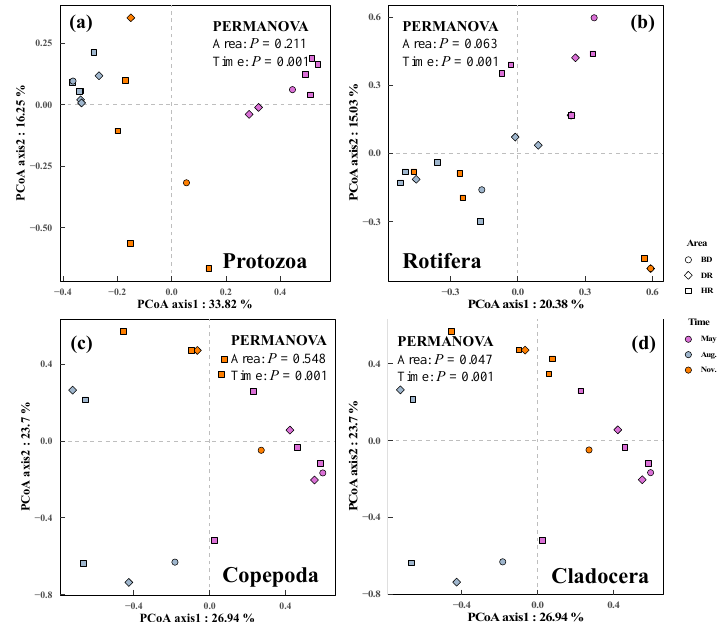
Figure A1. Plots of Principal Coordinate Analysis (PCoA) of the composition in the four taxonomic groups, with results of Permutational Multivariate Analysis of Variance (PERMANOVA) shown in top and right (or left) corner. ( a ) Protozoa, ( b ) Rotifera, ( c ) Copepoda, ( d ) Cladocera.